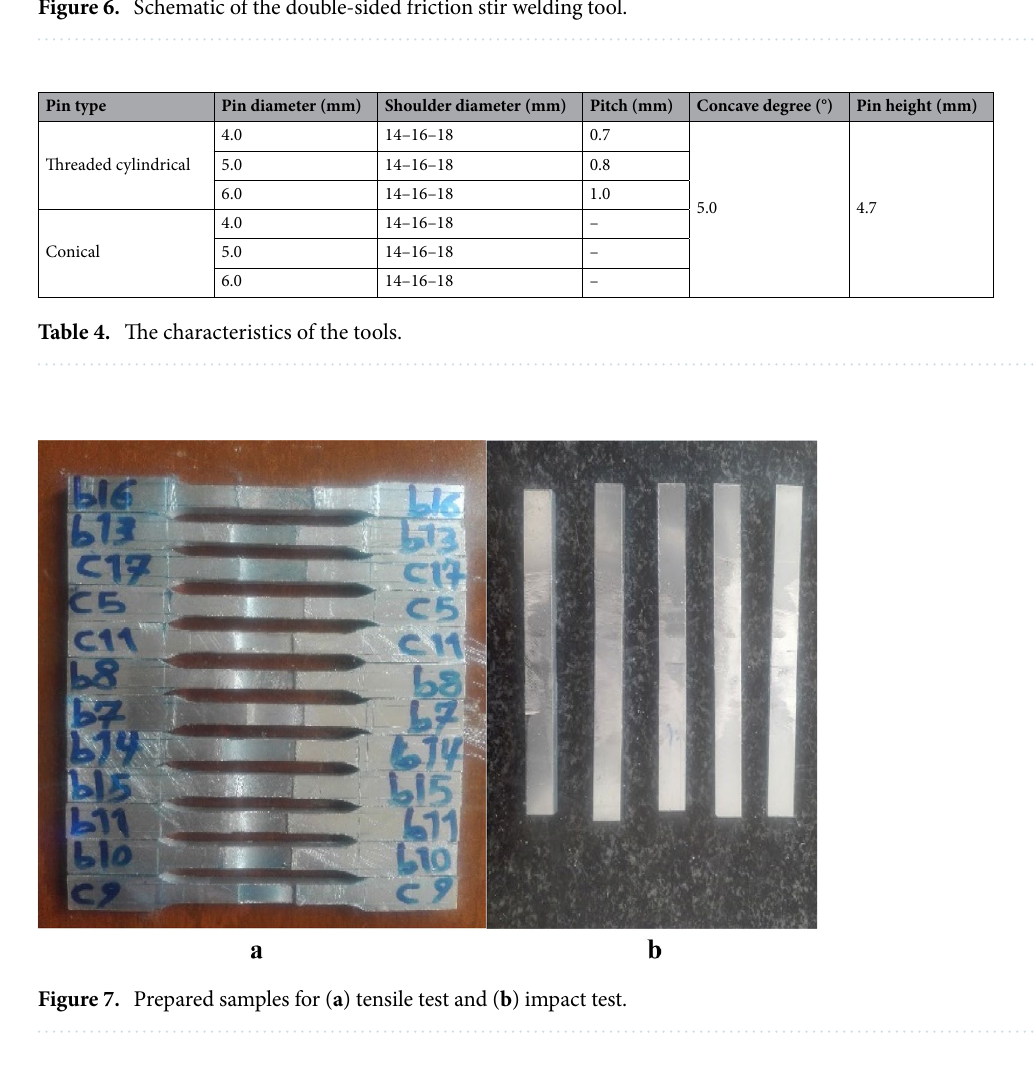
Figure 6. Schematic of the double-sided friction stir welding tool.